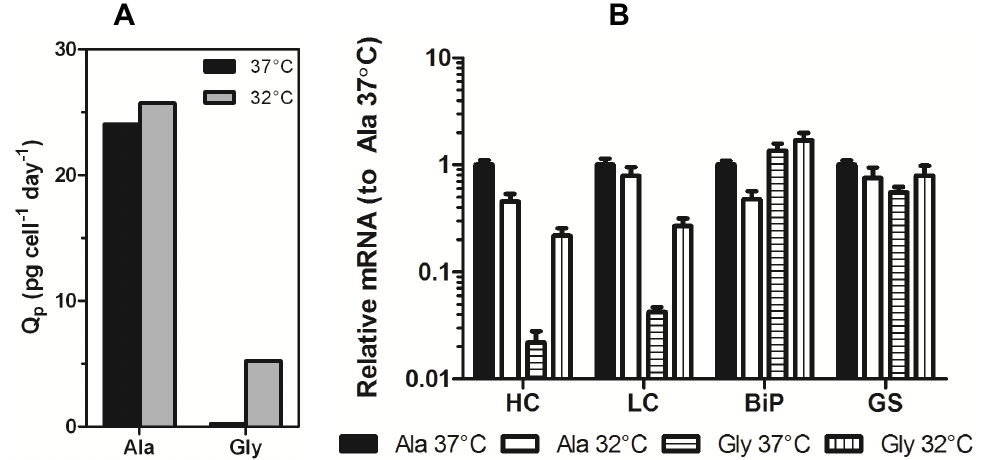
) of Ala-138 and Gly-26 mAb-producing clones in Figure 3. ( A ) Specific productivity (Q p the mid-exponential growth phase at 37 °C, days 3–6 (black bars) and 32 °C, days 6–9 (gray bars). ( B ) Expression of HC, LC, BiP, and GS mRNA in Ala-138 and Gly-26 clones on day 4 at 37 °C or 32 °C incubation temperature. The mRNA levels for each gene were calibrated to Ala-138 at 37 °C. The error bars represent ±1 standard deviation of technical replicates (n = 3). 37 °C cultures were compared with 32 °C using a paired t-test (GraphPad Prism 5.03) and found to be statistically different ( p = 0.0229 for Ala cultures and p = 0.0038 for Gly